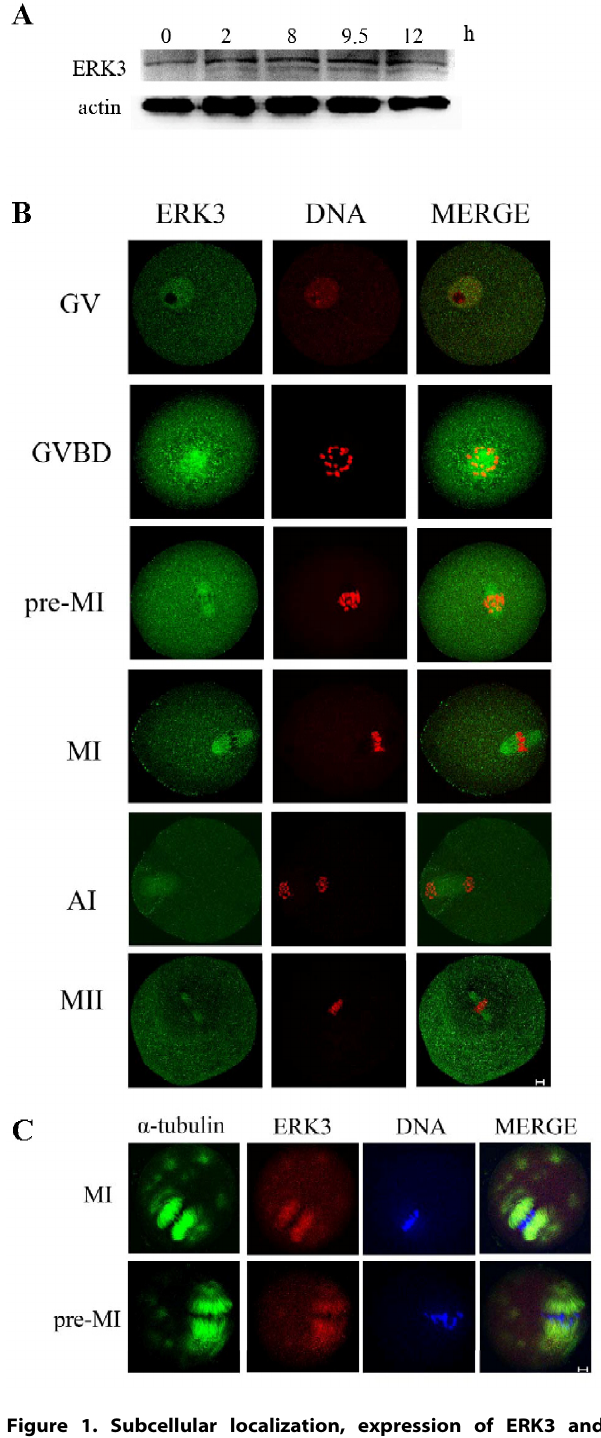
Figure 1. Subcellular localization, expression of ERK3 and localization of ERK3 treated with spindle-perturbing agents. (A) Samples were collected after oocytes had been cultured for 0.,2, 8, 9.5 and 12 h, corresponding to GV, GVBD, pre-MI, MI,ATI and MII stage, respectively. The molecular mass of ERK3 is 100 kDa and that of b -actin is 42 kDa. (B) Confocal microcopy showing immunostaining of ERK3 (green) and DNA (red) in oocytes at GV, GVBD, pro-M I, M I, A I and M II stages. (C) Oocytes at the metaphase I stage were incubated in M2 medium containing 10 m M taxol for 45 minutes and then double stained with antibodies against ERK3 as well as a -tubulin. Green, a -tubulin; red, ERK3; blue, DNA; yellow, overlapping of green and red. Each sample was counterstained with Hoechst 33258 to visualize DNA. Bar=10 m m.